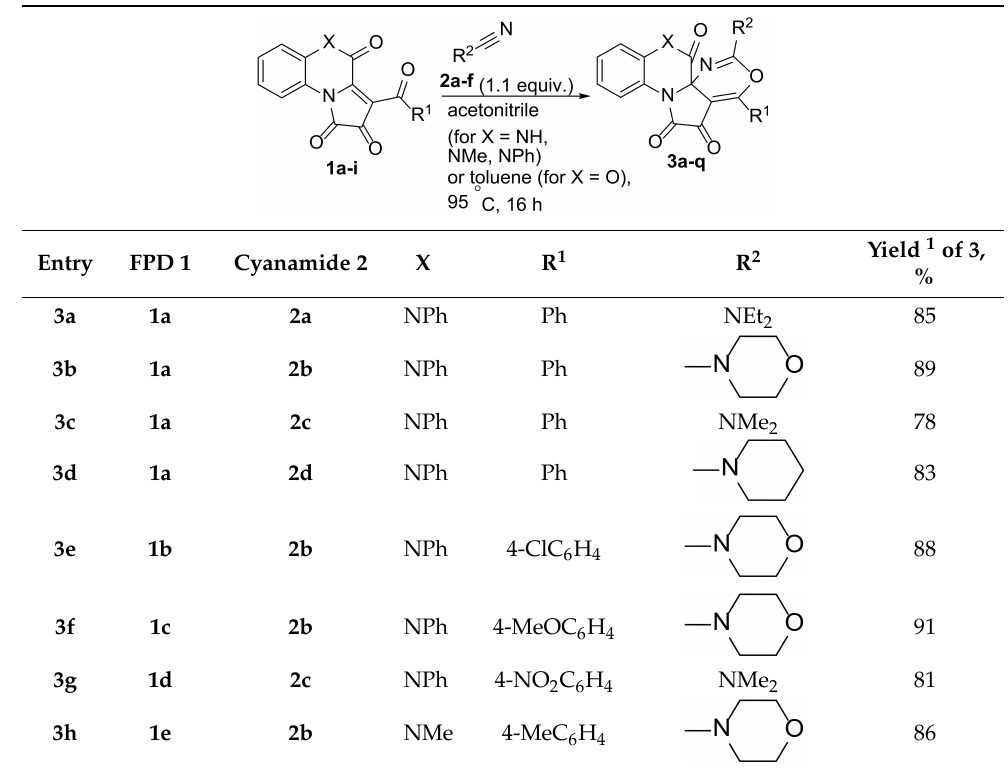
Table 1. Cycloaddition reaction of FPDs 1a–i with cyanamides 2a–f